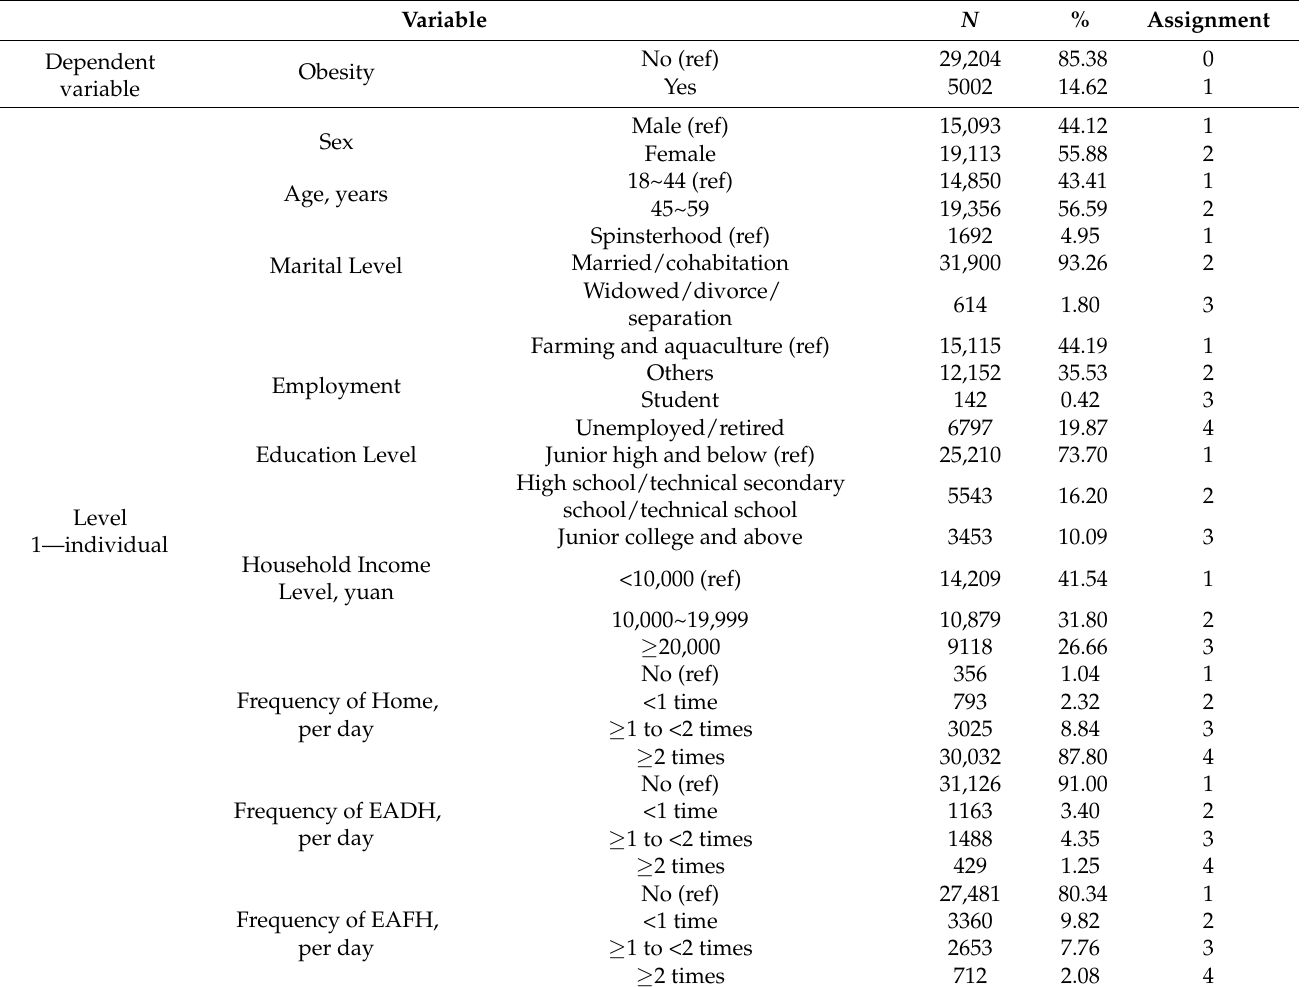
Table 1. Data distribution and assignment of classification variables.